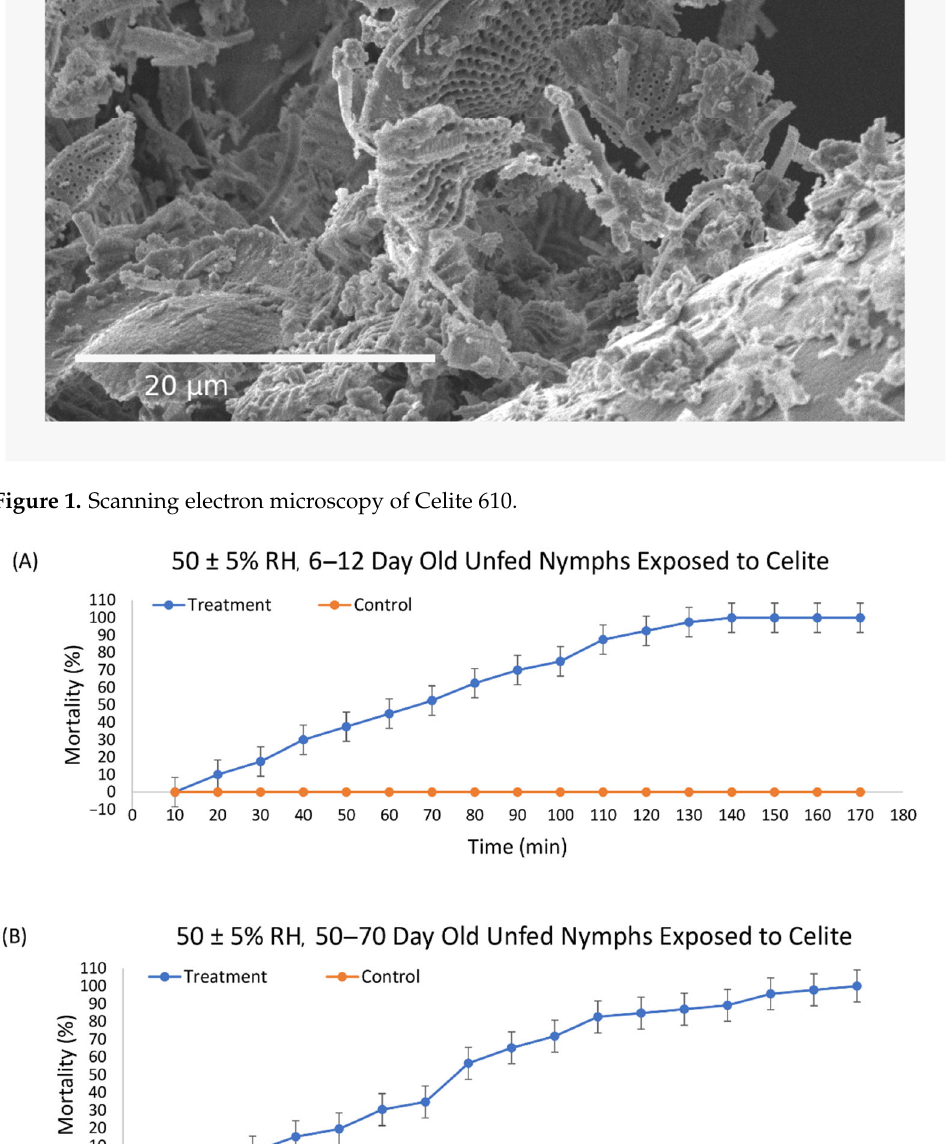
Figure 2. Mortality over time of unfed nymphal Ixodes scapularis exposed by dipping into Celite 610 with ( A ) ticks 6–10 days past last molt at 50 ± 5% relative humidity (RH), ( B ) ticks at 50–70 days past last molt at 50 ± 5% RH, and ( C ) ticks 50–70 days past last molt at 70 ± 5% RH. Probit models were used to determine the time to 50% mortality (LT 50 ) and time to 90% mortality (LT 90 ) (Table 1). The LT 50 for 6–10 d old unfed nymphs at 50% RH was 66.84 min (95% CI 62.12 to 71.43 min). The LT 90 was 113.42 min (95% CI 106.49 to 122.12 min). Ticks 50–70 d old at the same RH had an LT 50 of 81.68 min (95% CI 77.44 to 85.86 min) and an LT 90 of 128.31 min (95% CI 122.26 to 135.53 min). Higher age increased the time to death at the LT 50 and LT 90 by 1.2 ‐ and 1.1 ‐ fold, respectively. Ticks incubated at a higher RH died faster (Table 1). The 50–70 d old nymphs at 70% RH had an LT 50 of 43.84 min (95% CI 40.61 to 46.93 min) and an LT 90 of 69.46 min (95% CI 65.18 to 74.89 min) (Table 1). Increased RH decreased the time to death at both the LT 50 and LT 90 by 1.9 ‐ and 1.8 ‐ fold, respectively. To confirm mortality, all ticks were found to be dead at 24 h as well. The control ticks remained active and were walking around the assay arena throughout the assays, while the ticks exposed to Celite were obviously less active after dipping. They were quiescent, with some ability to move their legs while laying on their backs, and some were able to crawl.